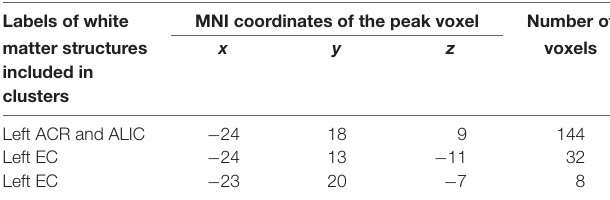
TABLE 2 | White matter structures whose AD values showed negative correlations with increases in verbal fluency task scores throughout the intervention